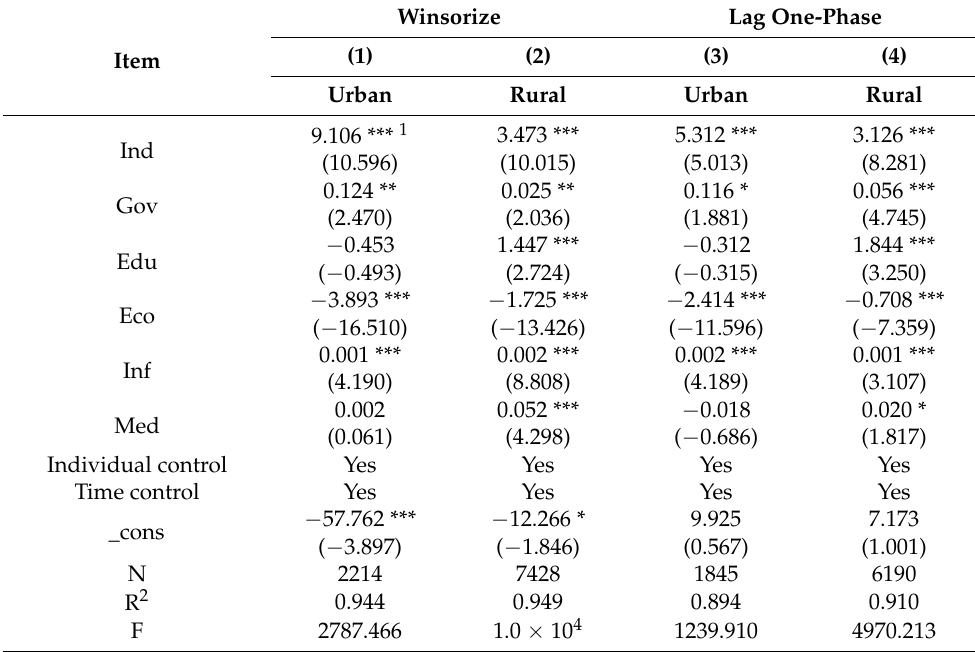
Table 4. Results of the robustness